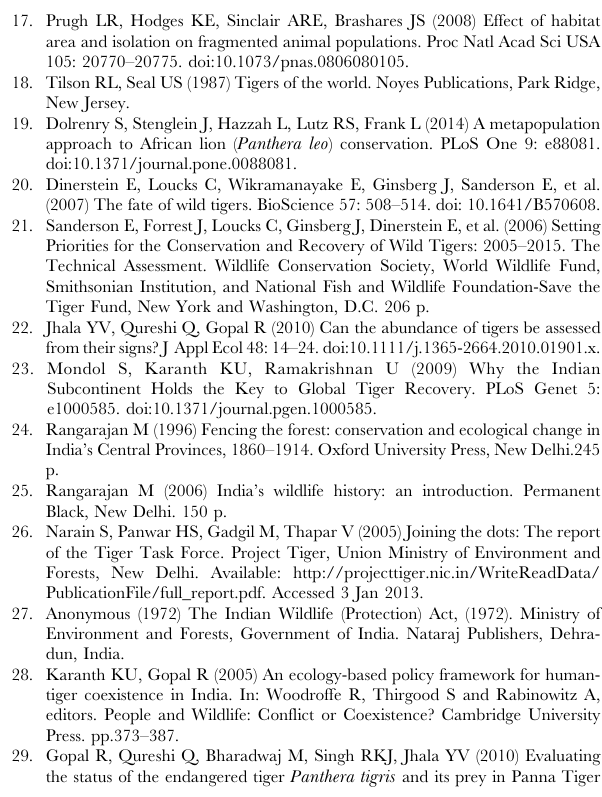
Table S4 AMOVA results. Table S5 Population pair-wise F ST (below diagonal) and R ST (above diagonal) estimates. Table S6 Bottleneck test results for loci under different mutation models. P values , 0.05 are depicted in italics. Table S7 Variable attributes used as site covariates in modeling tiger occupancy. Table S8 Habitat corridors, major roads, corridor cost between tiger reserves. Table S9 Results of standard and partial Mantel tests for correlation between pairwise genetic and spatial distance metrics. The correlation coefficient ( r ) and probability ( p ) are shown using three different genetic distance estimators. Significant values ( p , 0.05) are indicated by an asterisk (*). Table S10 Details of cyt b PCR amplification in reference samples using felid-specific (187 bp) and universal primers (309 bp). + indicates all samples which amplified. NA – not amplified. Table S11 Information on the pilot test carried out on scats ( n = 65) for species identification of tiger samples by PCR and Bam HI restriction enzyme